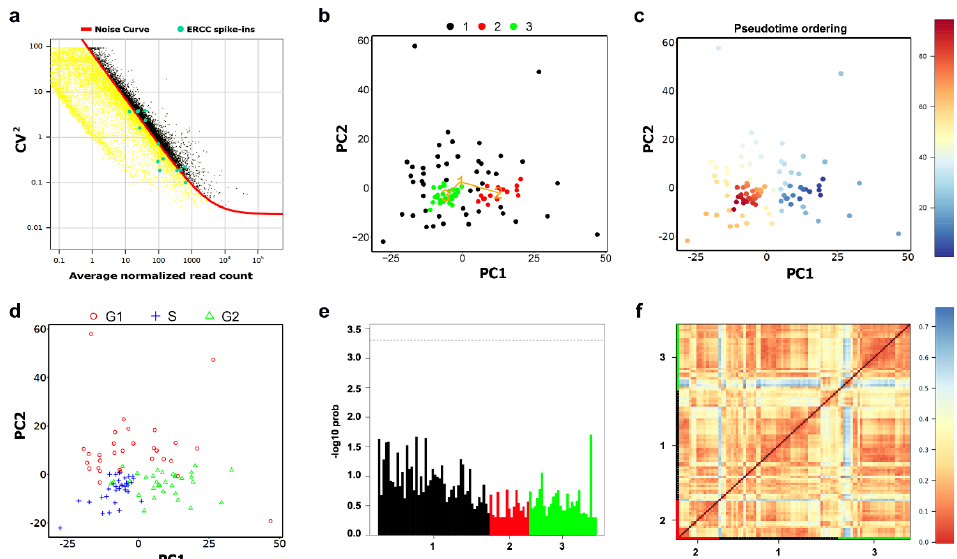
Figure 6. Identification of the MLS sub-populations. ( a ) Gene filtration by accounting for technical noise based on the variation and expression of the ERCC spike-ins. ( b ) PCA plot visualizing clusters identified using model-based clustering. ( c ) The plot from ( a ) with cells colored based on their pseudo-time ordering. ( d ) The plot from ( a ) with cells labeled based on their cell cycle phase. ( e ) A bar-plot of the outlier probabilities of all cells across clusters. ( f ) A heatmap portrayal of cell-to-cell distances; cluster centers were ordered by hierarchic clustering.